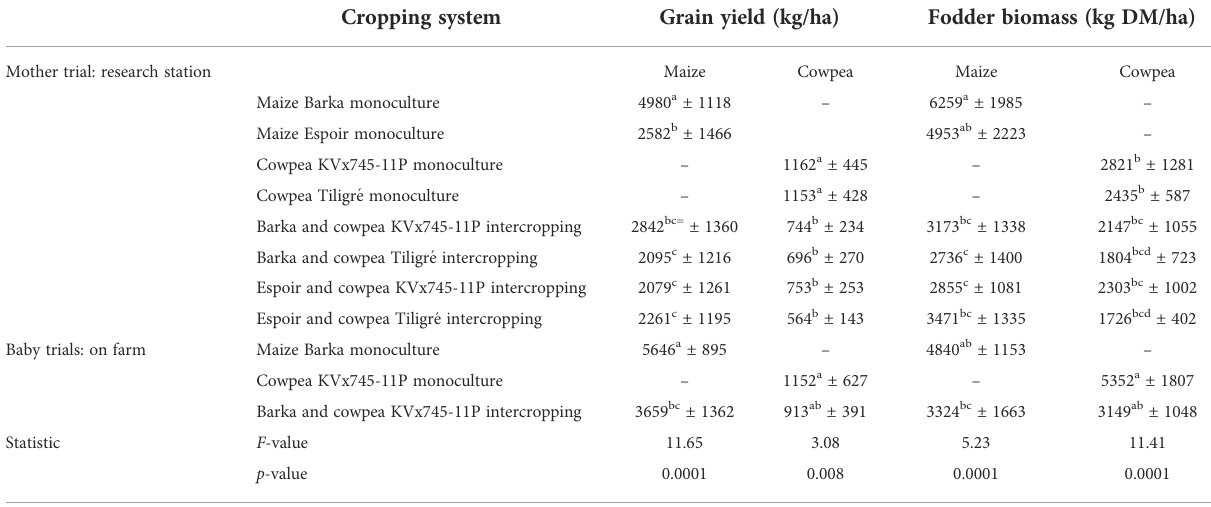
TABLE 6 Grain yield and fodder biomass of maize and cowpea in two cropping systems in on-station and on-farm experiments (mean from 2019 and 2020 cropping seasons). Cropping